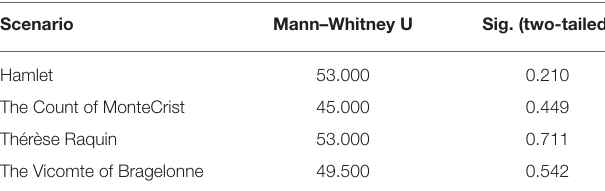
TABLE 8 | Audience studio: simple matching coefficients (global emotion